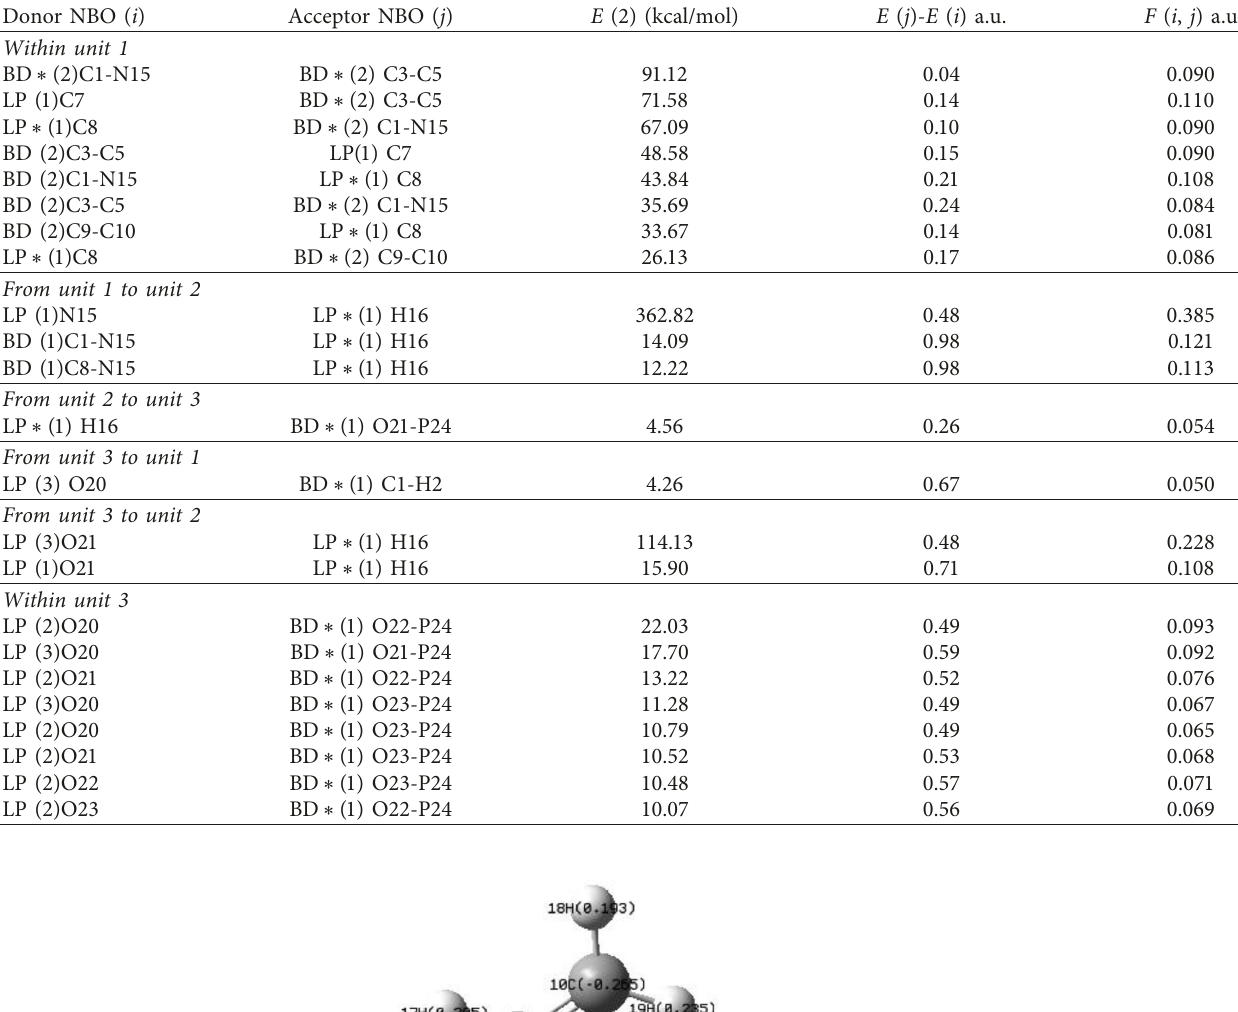
Table 3: Second-order perturbation theory analysis of the Fock matrix in NBO basis for 3M2VPP.